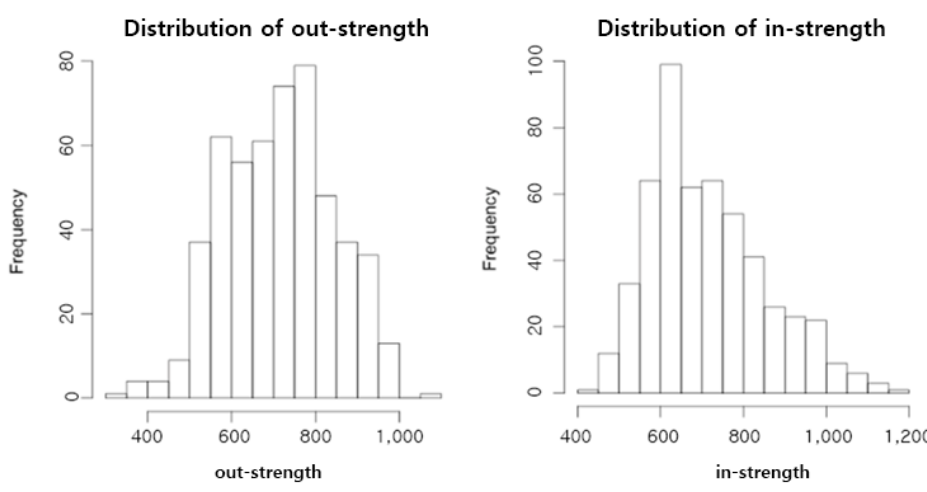
Figure 3. Distribution of the network for in- and